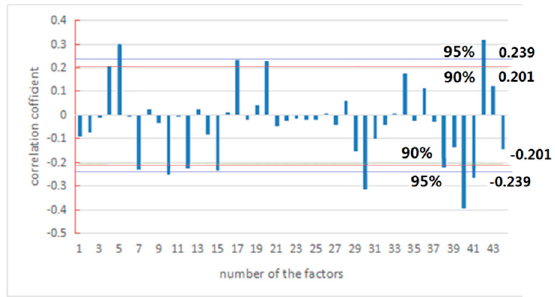
Figure 9. Correlation between precipitation and influencing factors.